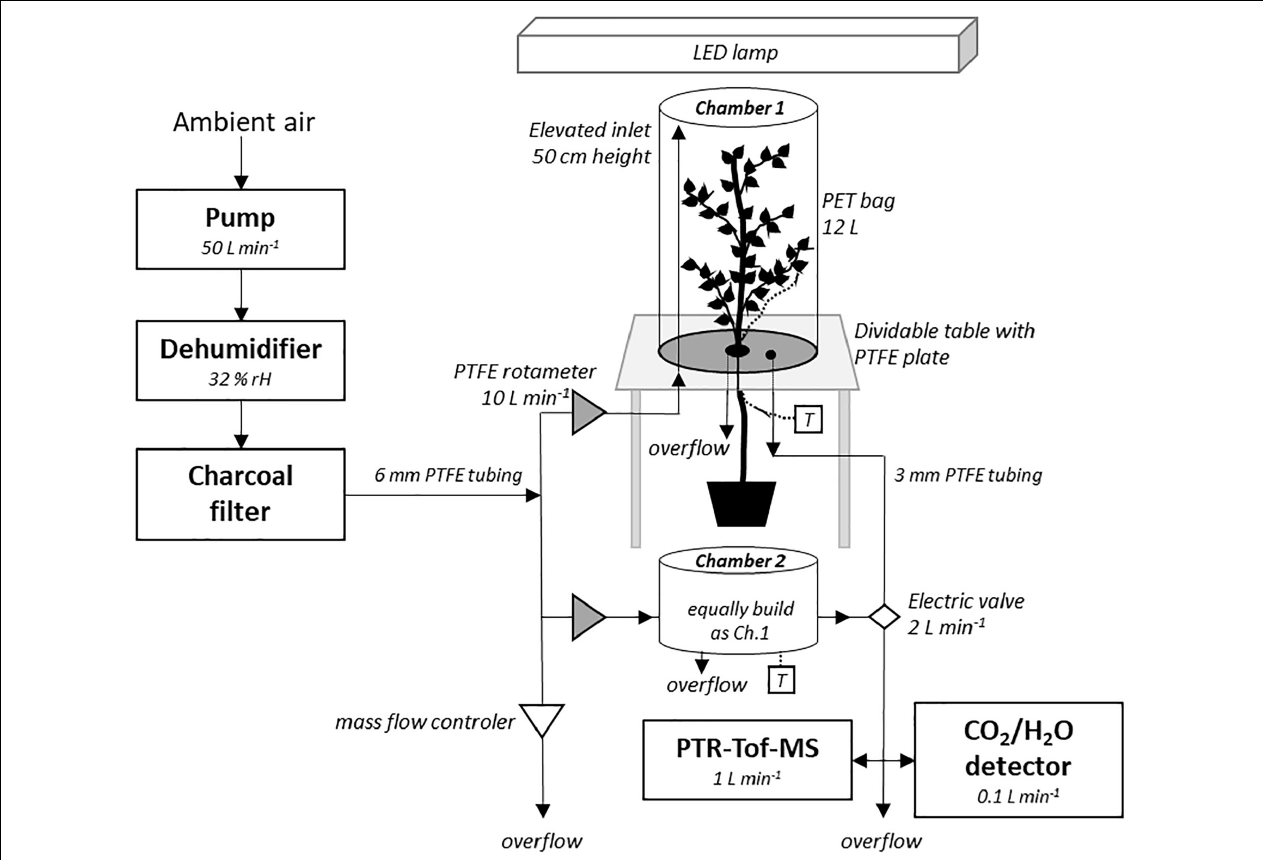
FIGURE 1 | Setup of the experiment of the VOC chambers. Ambient air was flushed through the dehumidifier (32% RH) and the charcoal filter for providing close-to VOC-free air. The incoming air was entering each chamber through an elevated inlet. A mass flow controller was regulating the incoming air pressure. The PTFE-covered table was dividable, allowing for tree insertion, and sealed with a PTFE-coated silicon stopper. A tree was inserted into chamber 1, whereas chamber 2 remained empty for parallel VOC background measurements. A thermocouple (T) was installed at both chambers. A PET-bag was placed over the bottom plate and sealed. Two outlets in the bottom of the PTFE plates of each chamber were used as overflow and for gas analysis by the PTR-TOF-MS and CO 2 /H 2 O detector, respectively. See “Materials and Methods” for details, and Supplementary Figure 1 for images of the